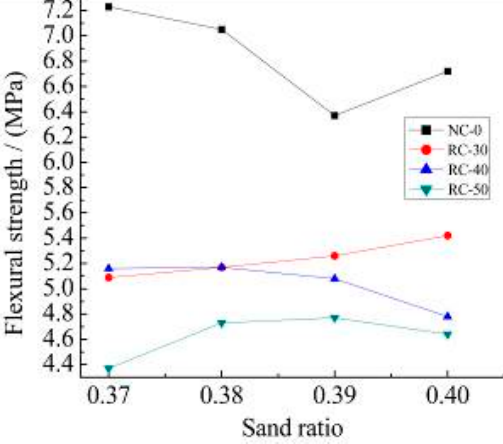
Figure 9. Measured flexural strength.